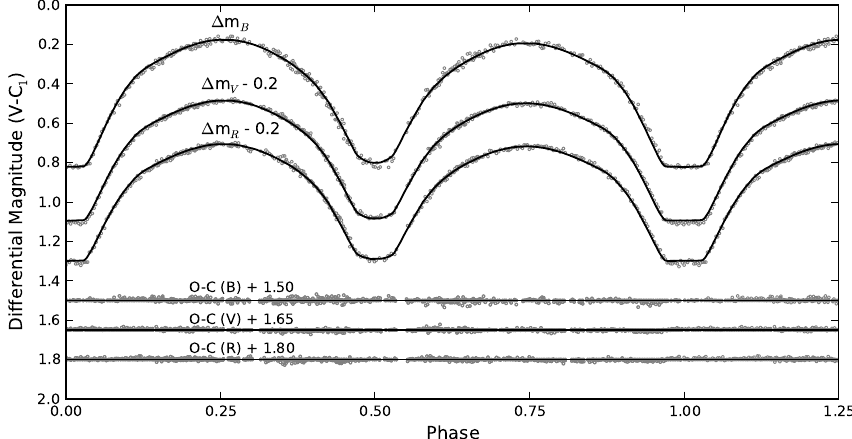
Fig. 5. Observational (filled circles) and synthetic (solid lines) BVR light curves for BB Peg obtained on 2009 October 4 and 6. The rest is the same as in Figure